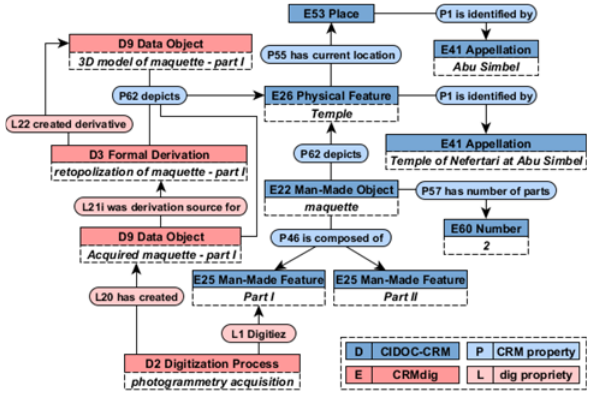
Figure 7. Graph representing data about the depicted